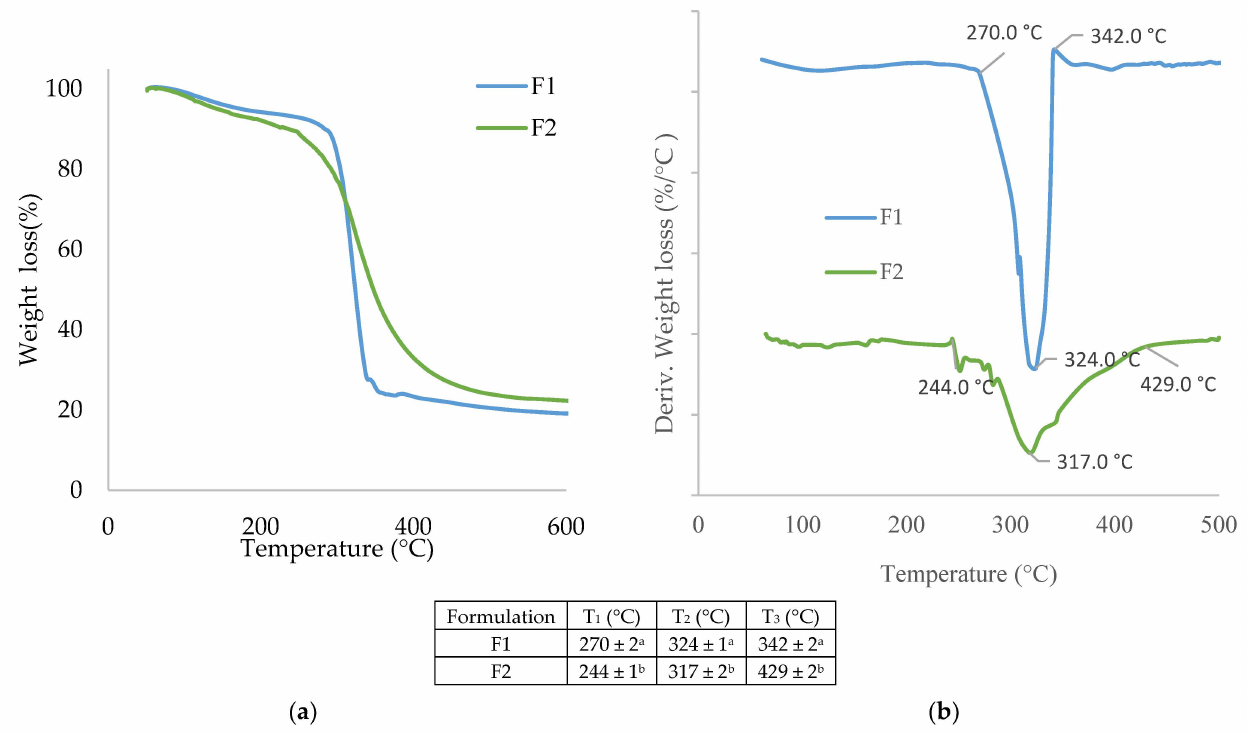
Figure 4. ( a ) Thermogravimetric analysis (TGA) and ( b ) first derivative (DTG) curves of films based on starch (F1) and wheat gluten (F2). Different superscripts within the same column indicate significant differences among samples ( p <